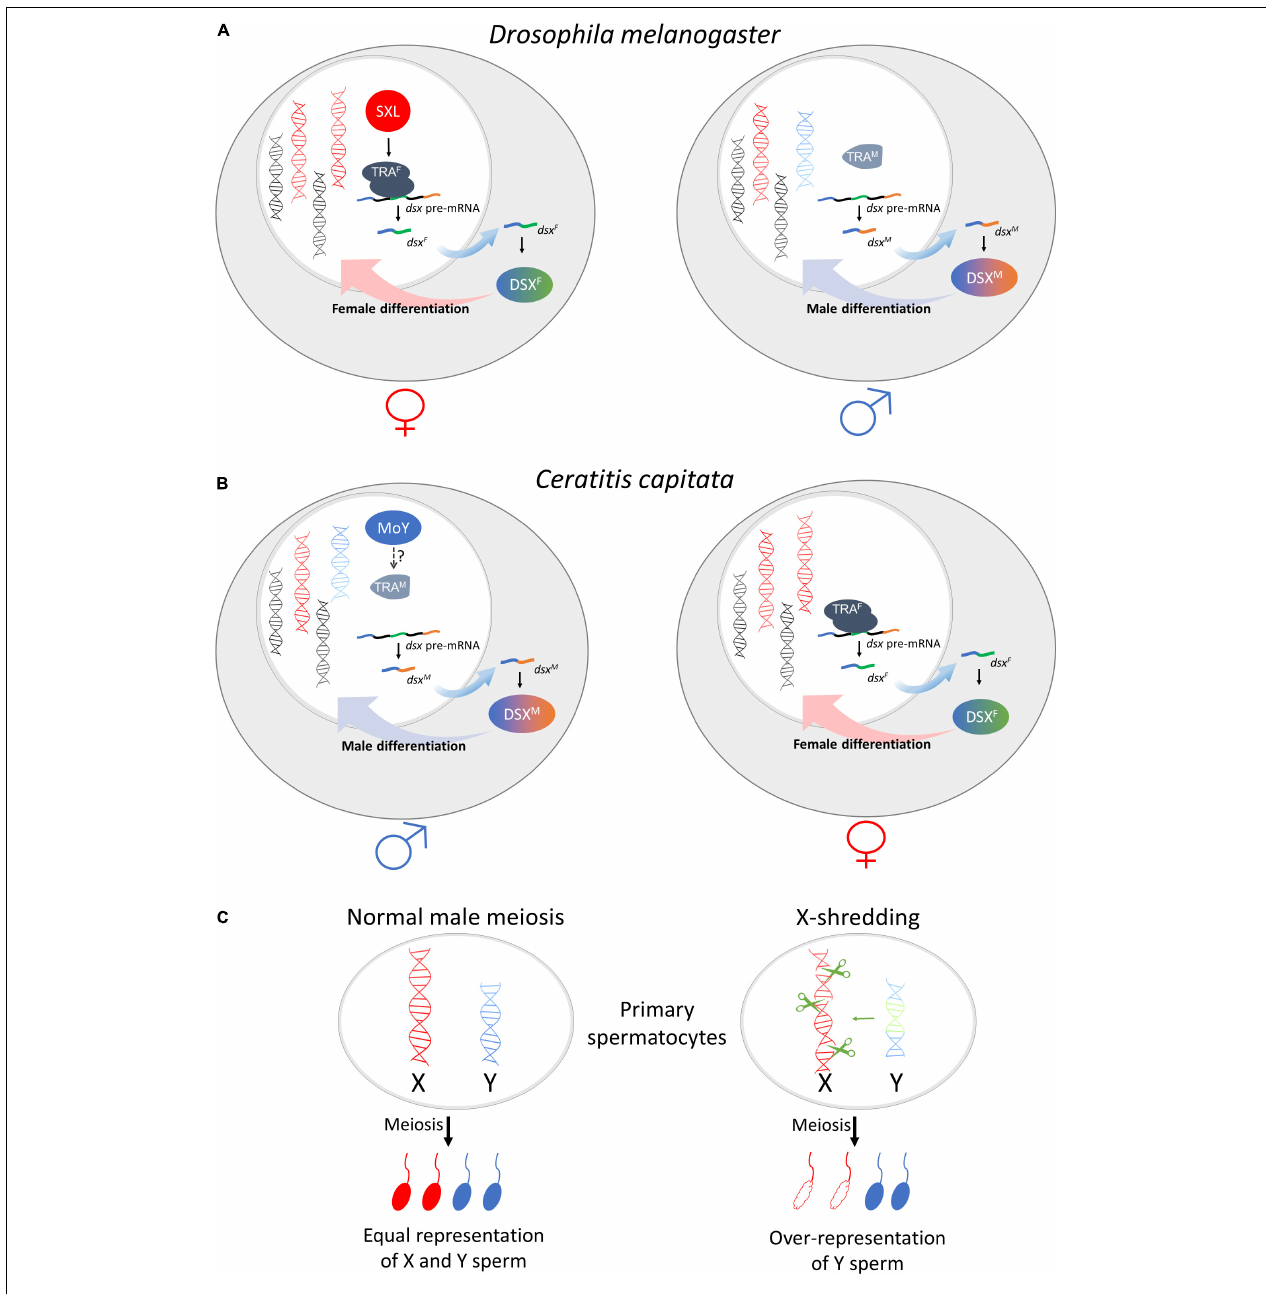
FIGURE 1 | Simplified models of the sex-determination pathways in the vinegar fly Drosophila melanogaster (A) and the Mediterranean fruit fly Ceratitis capitata (B) , and meiotic sex ratio distortion (C) . (A) In D. melanogaster , embryos that inherit two X chromosomes (depicted as red DNA molecules) express the primary signal Sex-lethal (SXL) which effects the female-specific splicing of the transformer ( tra ) transcript, leading to the production of a functional TRA protein (TRA F ). The TRA F protein complex enables the female-specific splicing of the doublesex pre-mRNA, leading to the production of the female DSX protein isoform (DSX F ) which programs female differentiation (left). In contrast, embryos with a single X chromosome do not express a functional SXL, resulting in a truncated non-functional TRA (TRA M ) and subsequently the default male-specific splicing of dsx . This leads to the production of DSX M , which programs male differentiation (right). The Y chromosome (depicted as a blue DNA molecule) does not directly participate in sex-determination. (B) In C. capitata, a dominant male-determining factor, Maleness-on-the-Y ( MoY ) resides on the Y chromosome (in blue). Expression of MoY somehow induces male-specific splicing of the tra pre-mRNA, leading to the production of truncated and non-functional TRA proteins (TRA M ). The lack of a functional TRA results in male DSX M isoform and male differentiation (left). Embryos that do not inherit the Y chromosome (or MoY ) produce a functional TRA protein (TRA F ) complex by default, which leads to the production of DSX F and female differentiation (right). See Meccariello et al. (2019) and Primo et al. (2020) for details and for the concept of an autoregulatory loop. (C) Normal spermatogenesis of a heterogametic male with XY chromosomes will produce X- or Y-bearing sperms in equal proportion (left). In a hypothetical Y-linked X-shredder system (right), either natural or engineered, double-stranded DNA breaks along the X chromosome could lead to non-functional X-bearing sperms without affecting the Y chromosome-bearing sperms. As a result, sex ratio distortion will occur in the progeny of an affected heterogametic male (XY).